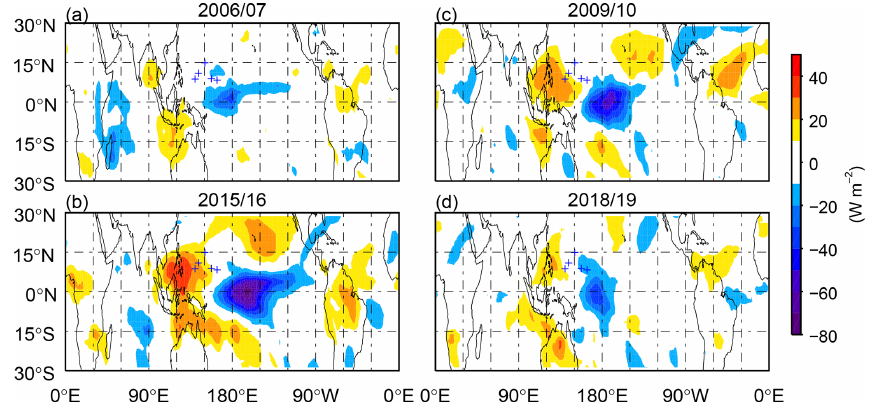
Figure 12. OLR anomalies averaged over the (a) 2006/07, (b) 2015/16, (c) 2009/10, and (d) 2018/19 winters. The blue pluses denote the five radiosonde